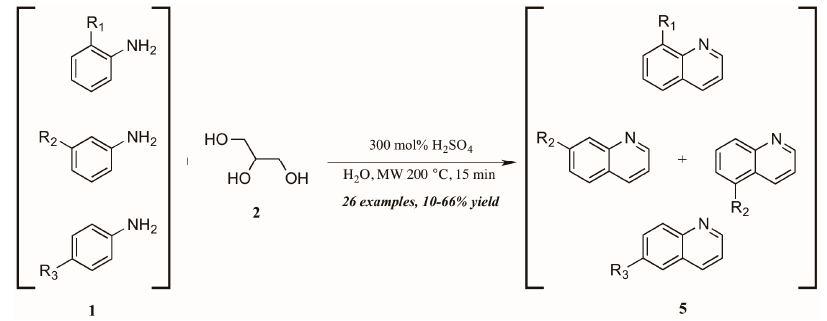
Figure 5. Skraup reaction under microwave irradiation.